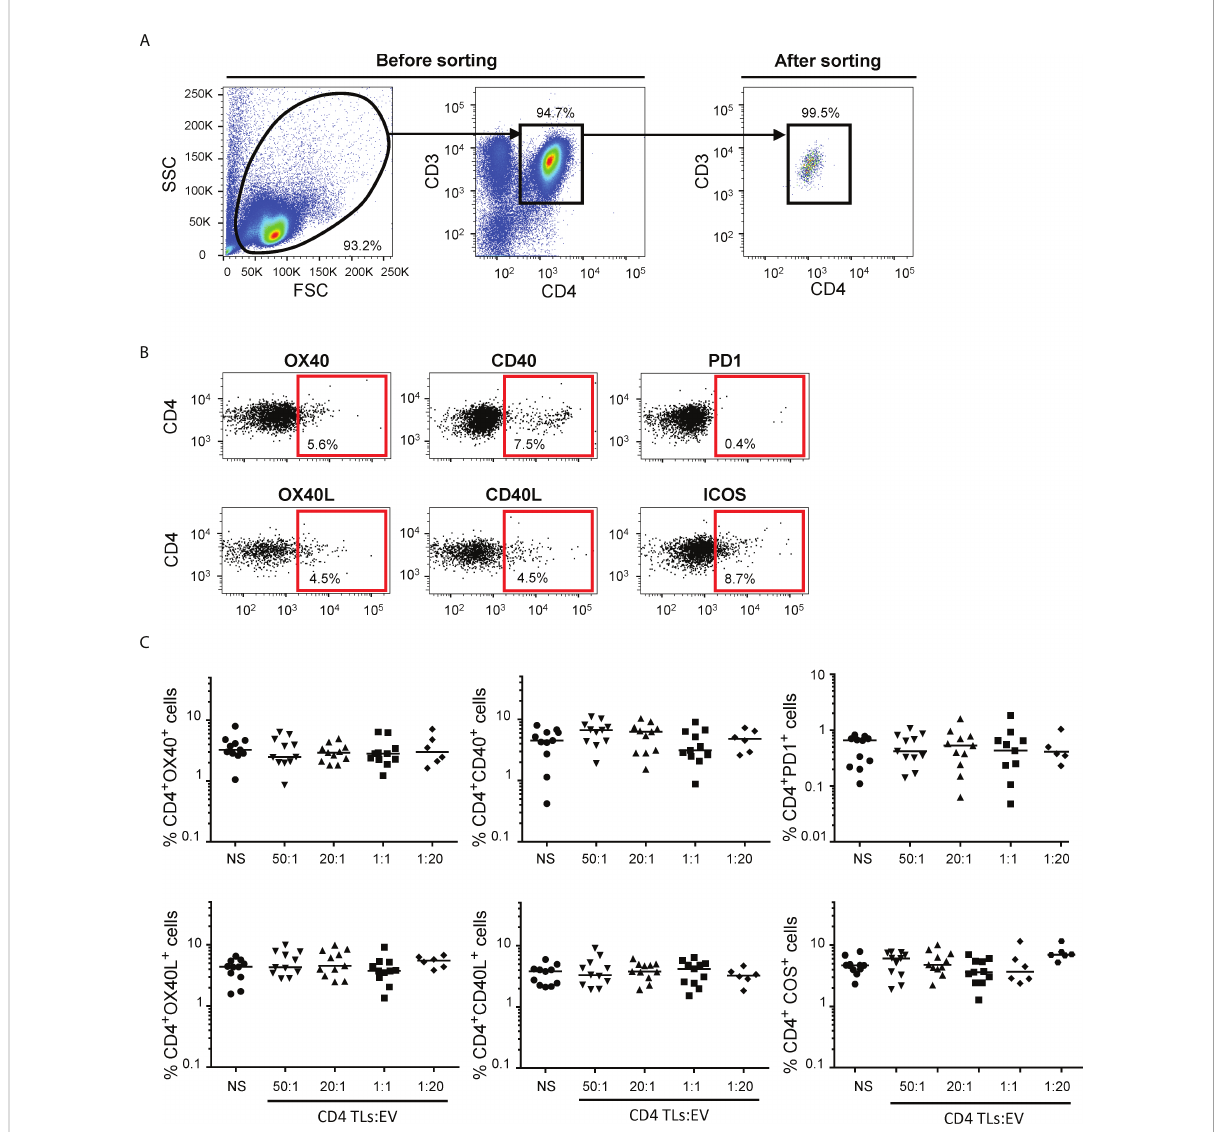
FIGURE 1 Flow cytometry analysis of CD4 + TL activation for cultures of sorted CD4 + TLs and autologous EVs. (A) Gating strategy for the sorting of CD4 + T cells. Dot plots for total enriched CD4 + TLs before (on the left) and after (on the right) sorting by fl ow cytometry. (B) Representative FACS plots from 11 experiments measuring the expression of OX40, OX40L, CD40, CD40L, PD1 and ICOS on CD4 + TLs. (C) OX40, OX40L, CD40, CD40L, PD1 and ICOS expression on the surface of CD4 + TLs cells was assessed after incubation without EVs ( ○ ) or treatment with total autologous EVs at ratios (CD4: EVs) of 50:1 ( ▾ ), 20:1 ( ▴ ). 1:1 ( ▪ ) (from 11 HDs) and 1:20 ( ♦ ) (from 6 HDs) for six days. Horizontal bars indicate the